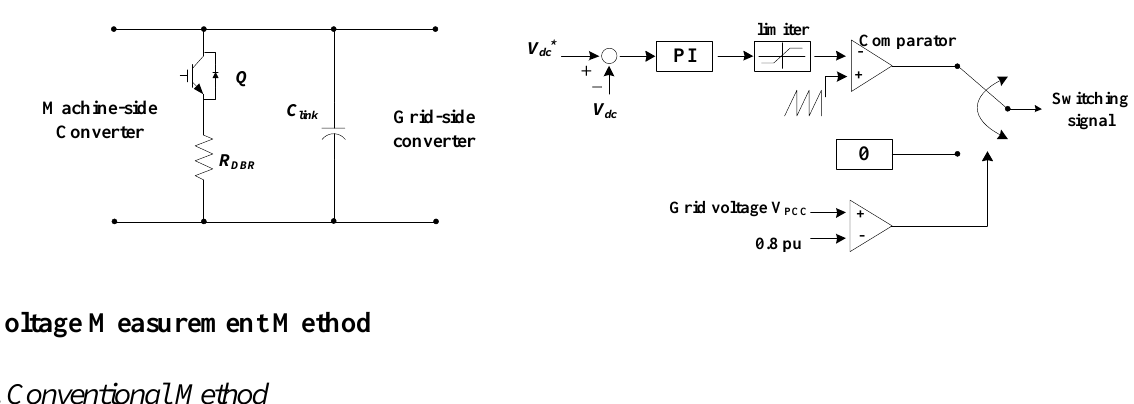
Figure 2. Configuration of a dynamic braking